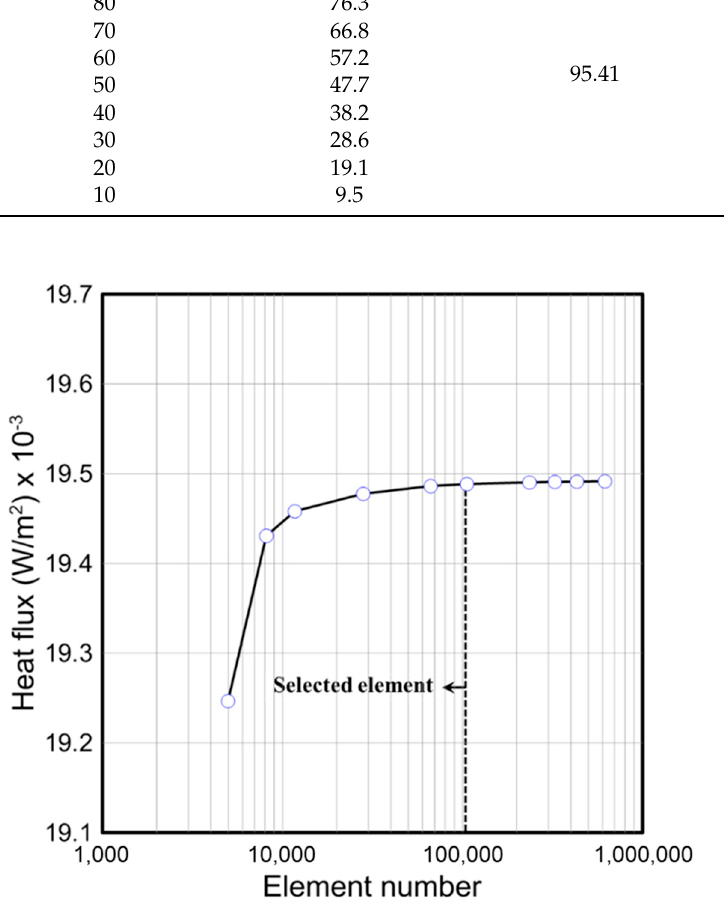
Figure 5. Results of mesh convergence test.